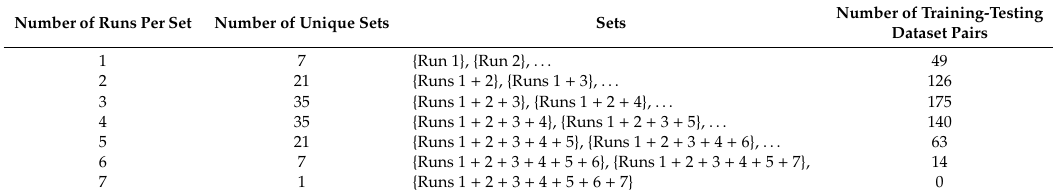
Table 2. Unique sets of runs based on number of runs (train-test pairs) included in each set. NumberofRunsPerSet Number of Unique Sets Sets Number of Training-Testing Dataset